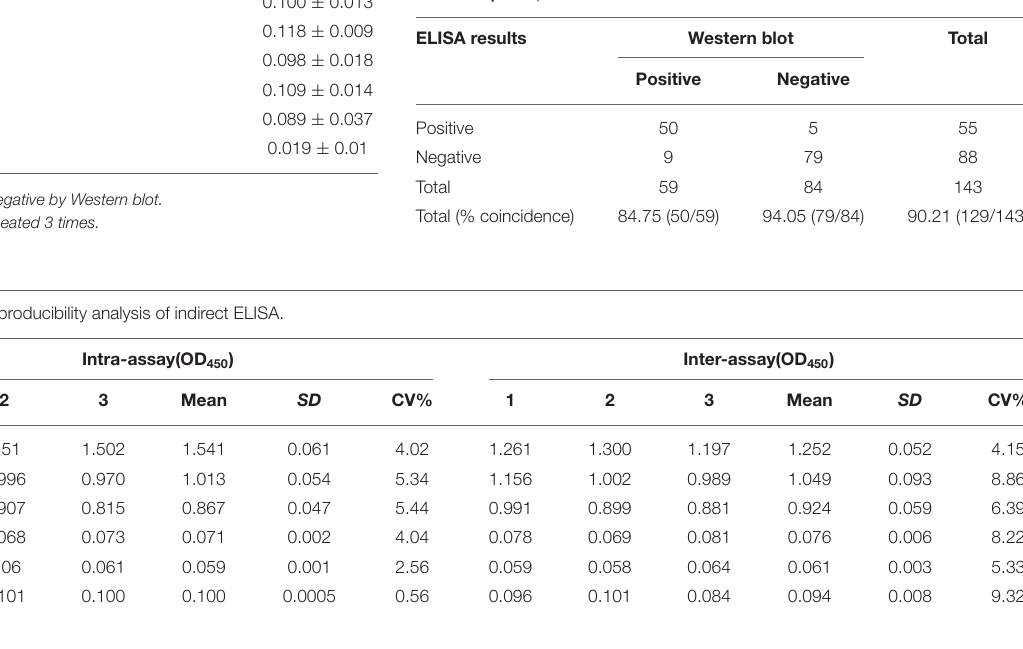
TABLE 4 | Comparison of the ELISA and Western blot test.